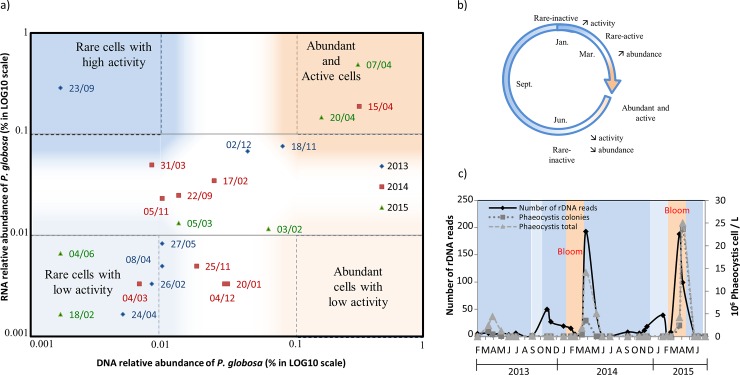
Relation between abundance (rDNA reads) and relative cell activity (rRNA reads) for Phaeocystis globosa.a) Relative rRNA and rDNA reads abundance corresponding to P. globosa between 2013 and 2015. Relative reads abundance for each sample were plotted on logarithmic scale. Considering abundance (rDNA-based data) and relative cell activity (rRNA-based data), four quadrants stand out: rare cells with low activity (DNA<0.01%, RNA<0.01%), rare-active cells (DNA<0.01%, RNA>0.1%), abundant-active cells (DNA>0.1%, RNA>0.1) and abundant cells with low activity (DNA>0.1%, RNA<0.01), respectively. Colors represent rDNA reads abundance (blue: rare, red: abundant), and shades represent rRNA reads abundance as proxy for relative cell activity (dark shade: active, light shade: low activity). b) Schematic representation of P. globosa annual pattern of abundance and activity in the EEC. c) Microscopic counts of P. globosa (dash light grey line: total number of Phaeocystis cells; dash dark grey line: number of Phaeocystis colony) and number of rDNA Illumina reads (black line).